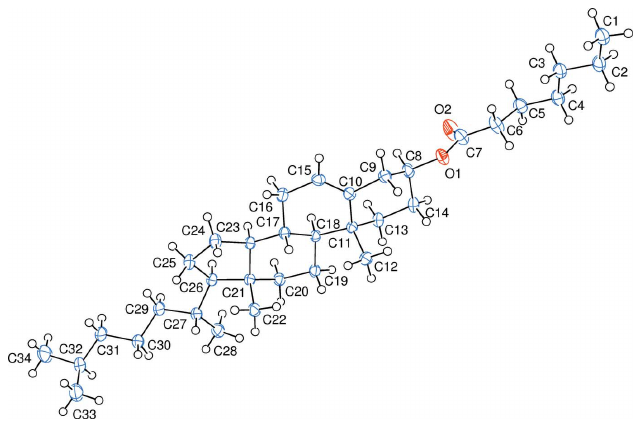
Figure 1 The asymmetric unit of the title compound with the atom-numbering scheme. Displacement ellipsoids are drawn at the 50% probability